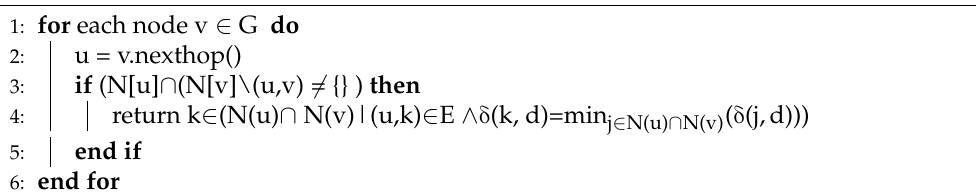
Algorithm 3 failure_handler(u,v,d) [Finding alternate path avoiding the failure]